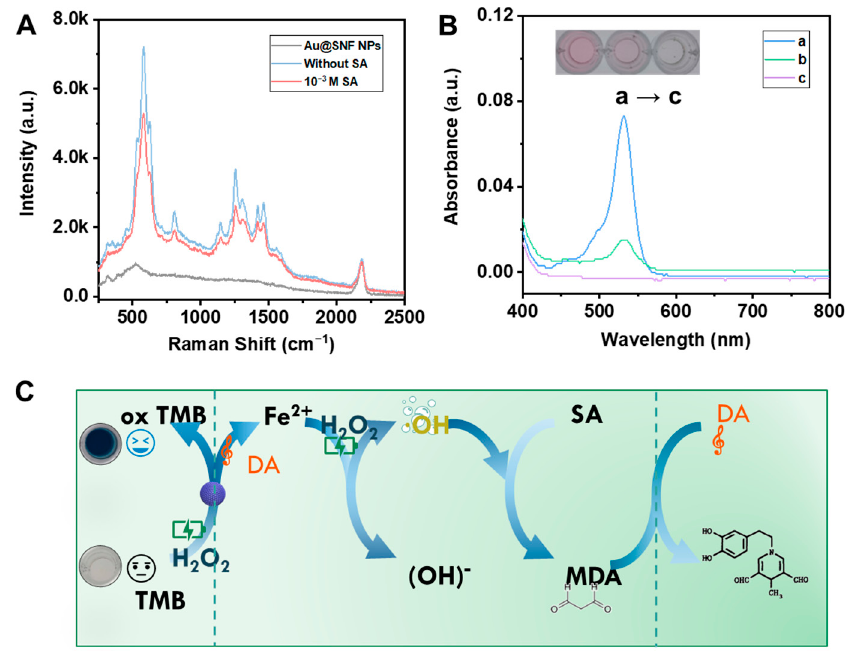
Figure 4. ( A ) The SERS behaviors of the nanoenzyme reactor for detecting SA. ( B ) The UV-vis absorption spectra: (a) Au@SNF NPs/H 2 O 2 /malondialdehyde test kit/SA, (b) Au@SNF NPs/DA/H 2 O 2 /malondialdehyde test kit/SA, (c) Au@SNF NPs/H 2 O 2 /malondialdehyde test kit. ( C ) The mechanism of the nanoenzyme reactor for detecting